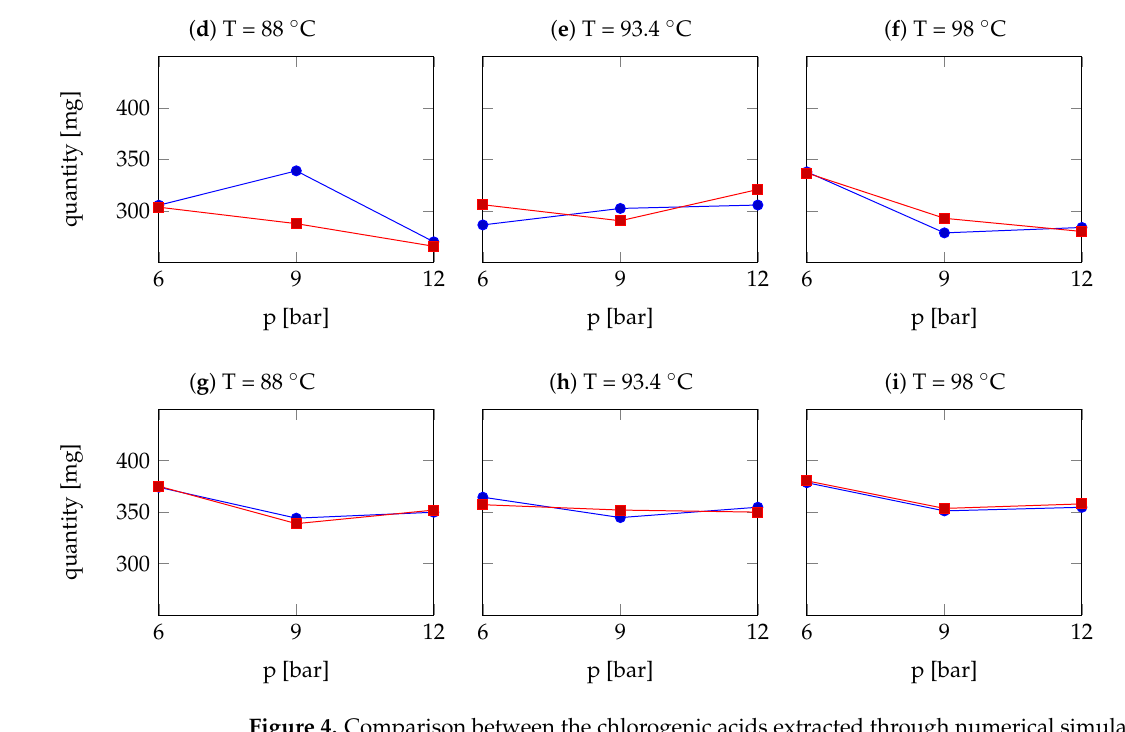
Figure 4. Comparison between the chlorogenic acids extracted through numerical simulations (blue profile with circles) and laboratory measurements (red profile with squares), with different inlet water temperatures and pressures and different grain size of Arabica coffee powder. Figures ( a – c ) show the results of optimal granulometry, Figures ( d – f ) of coarse granulometry and Figures ( g – i ) of fine granulometry.